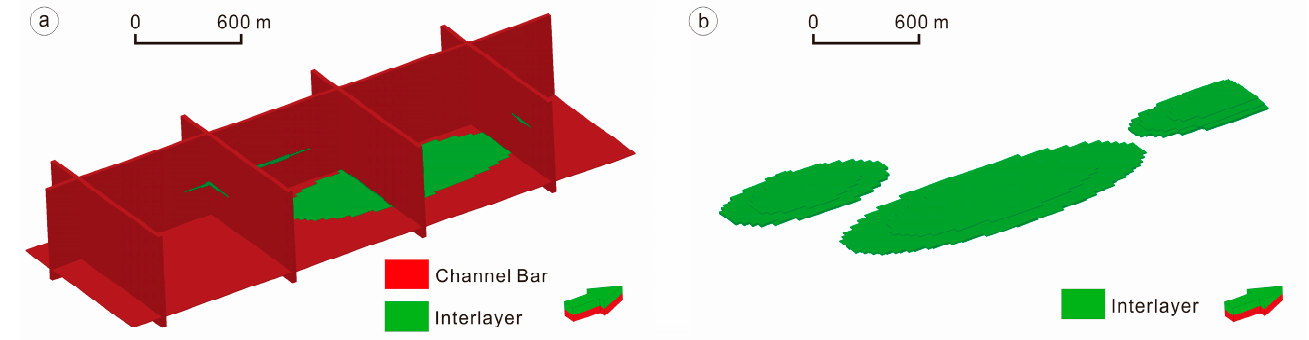
Figure 9. Second hierarchical multiple-point geostatistical simulation results in MPS-2 based on 5–4 level architecture units.